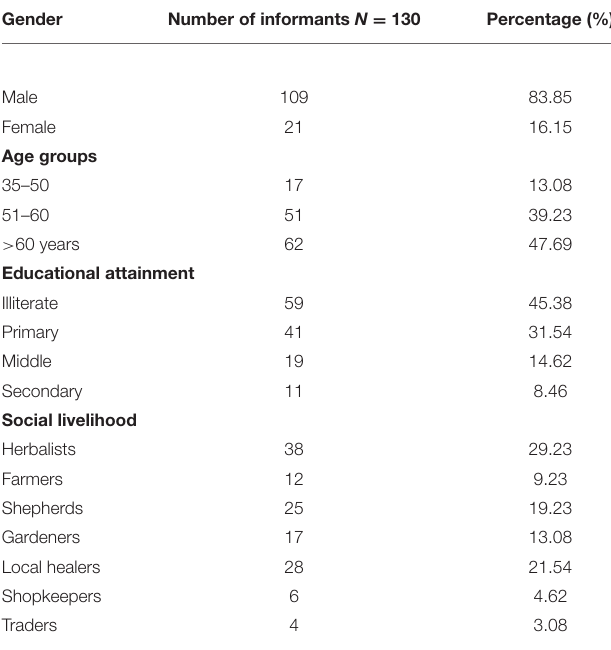
TABLE 1 | Demographic details of the informants interviewed during ethnoveterinary survey in the study